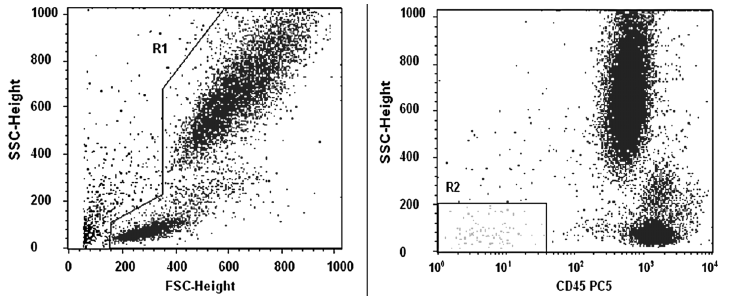
Figure 1. Left , Forward side scatter (FSC) vs side scatter (SSC) cytogram in dot plots showing region 1 (R1) gating mononuclear cells and excluding debris and ( right ) CD45 –/dim vs SSC. R2: region 2; PC5: phycoerythrin-cyanin